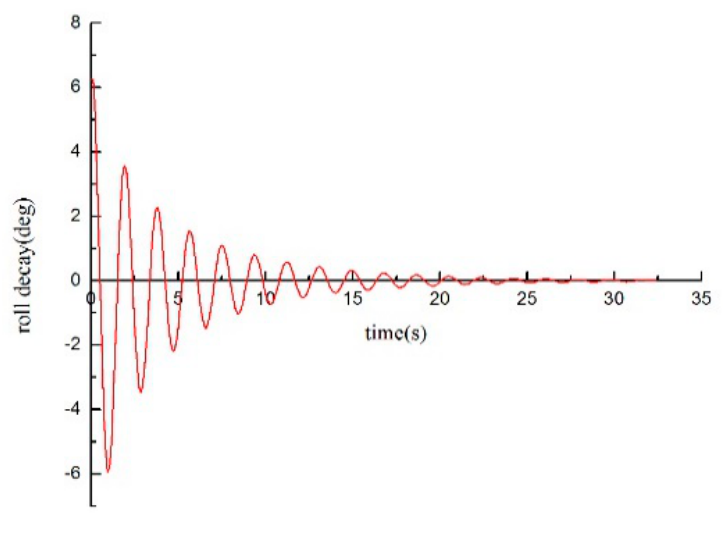
Figure 9. Decay curve of the roll motion.